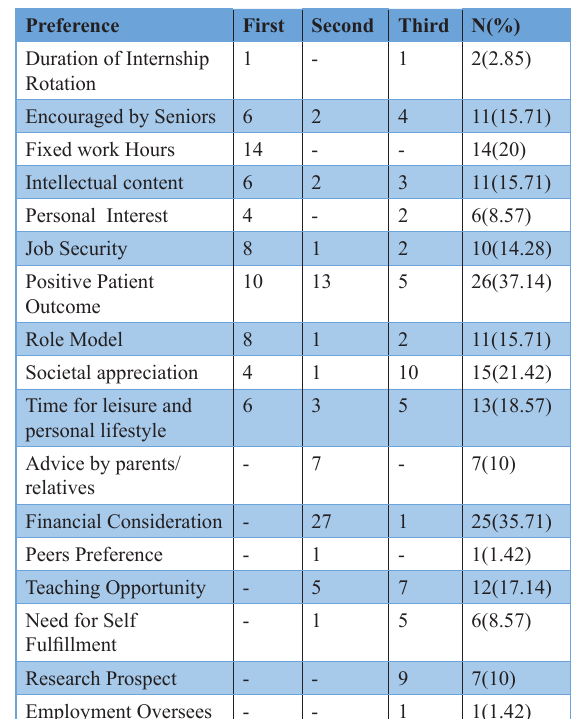
Table 3. Reasons for not choosing Anesthesia